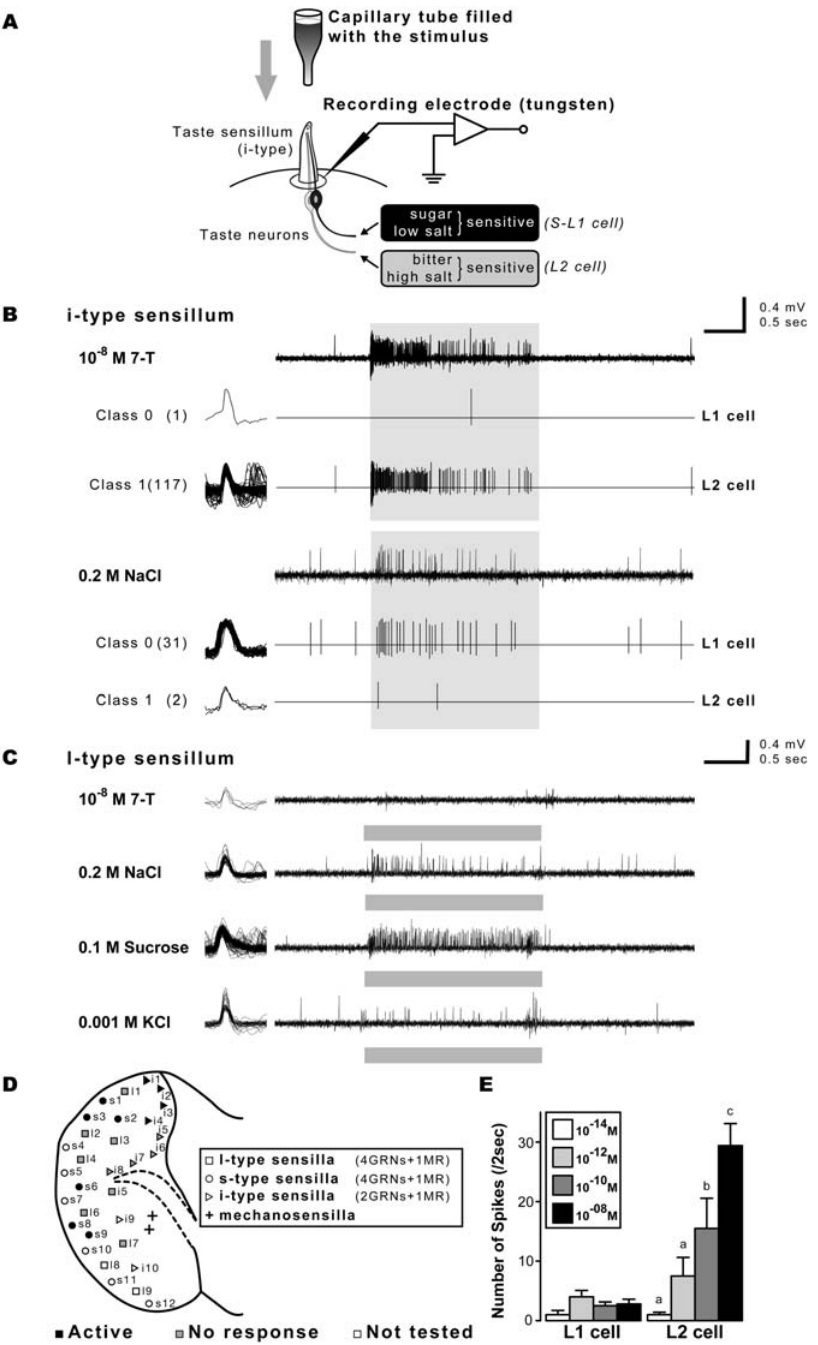
Figure 3. 7-T elicits a dose-dependent electrophysiological response in a subset of labial palp gustatory neurons. (A) Schematic illustration of the ‘‘tungsten electrod method’’ which allows simultaneous but separate stimulation and recording of gustatory and pheromonal stimuli. The stimulus was contained in a glass microelectrode capping the tip of the sensillum; caffeine and 7-T were dissolved in mineral oil, sucrose and salts were dissolved in water. Recordings were obtained from three types of labellar sensilla (l-, i- and s-type) determined according to both their location and shape [21–23] in wild-type Canton-S males. So far, we were unable to use this method to record from sensilla on the fore-tarsus, because of the relative hardness of the leg cuticle and the slender form of this appendage. (B) In i-type sensilla, one cell responded to 10 2 8 M 7-T, whereas the second cell responded to 0.2 M NaCl. The shaded bar represents the duration of the stimulation (2 sec). Elicited spikes were separated according to spike height (amplitude of ‘‘class 0’’ and ‘‘class 1’’ were 0.3–0.5 mV and 0.1–0.2 mV, respectively); see left side of panel; n=20 flies. ( C ) Conversely, l- type sensilla responded normally to NaCl, sucrose, KCl but not to 10 2 8 M 7-T. Recording were made in similar conditions as described for i-type sensilla; n=32 flies. (D) 7-T responsive sensilla were mapped on the labial palp with tungsten electrode recordings. Both i- and s-types-but no l- type—sensilla responded to stimulation with 7-T (a sensillum was considered as responsive if it showed at least one response to 7-T among 2-5 trials). Anterior is up, dorsal is right. GRN=gustatory receptor neuron; MR=mechanoreceptor neuron. (E) In a s-type sensillum (S2), the L2 cell showed a dose-dependent increased activity to 7-T (between 10 2 12 and 10 2 8 M) while the L1 cells were not activated. Vertical axis: total number of spikes during 2 sec stimulation. Significantly increased activity of the L2 cell is indicated (a–b: p , 0.05, a–c: p , 0.01; n=4–10).